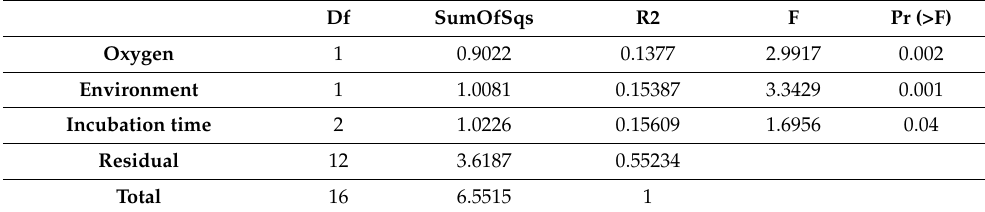
Table 1. Variation in bacterial community composition explained by oxygen (oxic/anoxic incubation conditions), environment type (sediment/leachate), or incubation time (12, 240 or 720 h), tested using PERMANOVA.